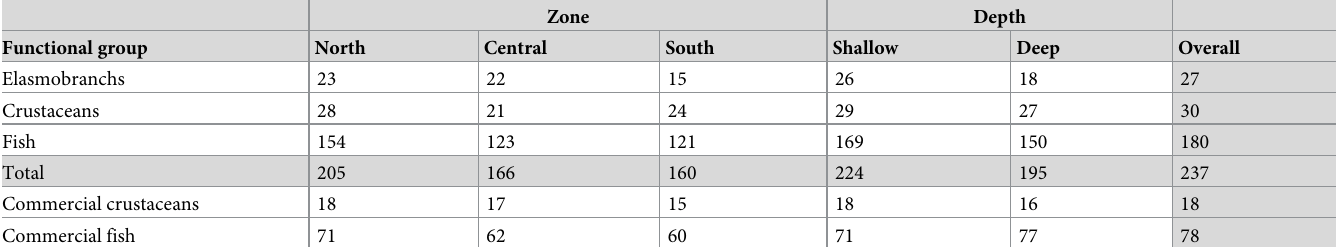
Table 2. Number of discard species or higher taxa summarised by study groups by fishery zone and depth ( < = 75 m is shallow and > 75 m is